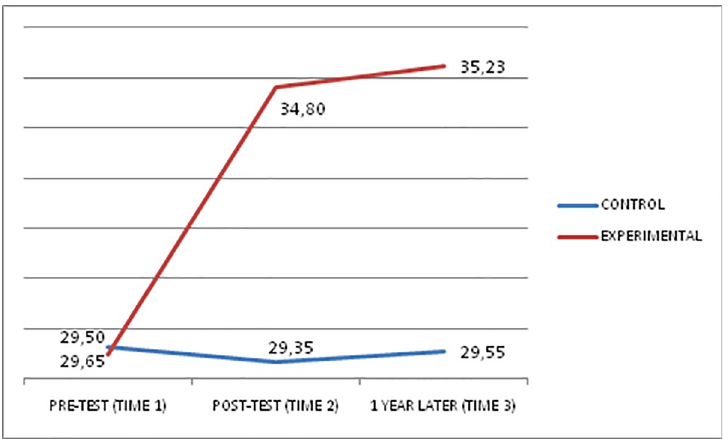
Fig 1. Total EQi performance of the groups at pre-test (Time 1), post-test (Time 2), and one year after (Time